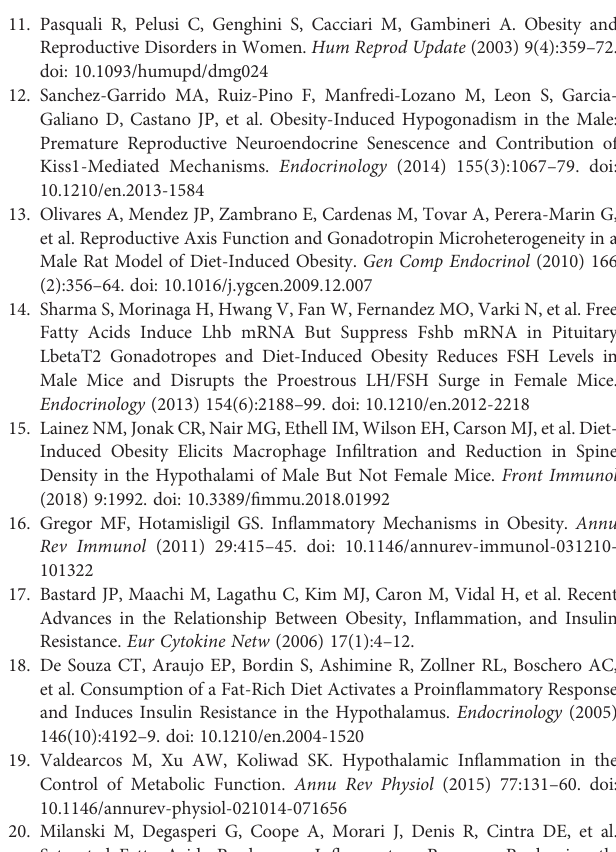
measured in the liver of rats fed control, HF or HF-DHA diets for 20 weeks. Data are expressed as means ± SEM (n= 12 rats) and were analyzed with one-way ANOVA followed by Tukey ’ s multiple comparison test. * P ≤ 0.05; ** P ≤ 0.01; *** P ≤ 0.001 compared to control group. a P< 0.05 between HF and HF-DHA groups. Supplementary Figure 2 | Metabolic parameters and body composition of rats fed HF diet supplemented with 15% DHA. (A) Fasting plasma levels of insulin, leptin and triglycerides were measured in rat fed control, HF and HF supplemented with 15%DHAfor 12weeks. Data are expressed asmeans ± SEM(n=12 rats) andwere analyzed with one-way ANOVA followed by Tukey ’ s multiple comparison test. * P ≤ 0.05; ** P ≤ 0.01; *** P ≤ 0.001 compared to control group. b P ≤ 0.01 between HF and HF-DHA15%. (B) The body composition of rats (% fat and lean mass) was measured after 12 weeks of diet. ** P ≤ 0.01; *** P ≤ 0.001 compared to control group. b P ≤ 0.01 between HF and HF-DHA groups.